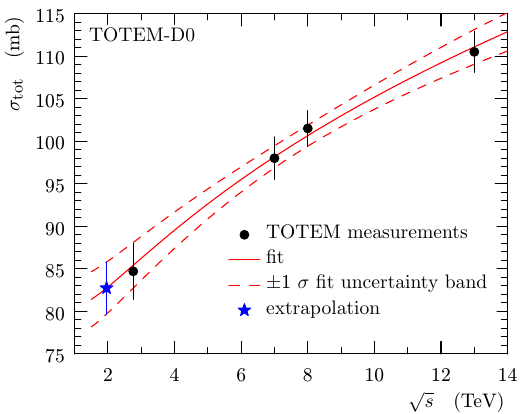
(cid:112) s measured by the TOTEM collabora-